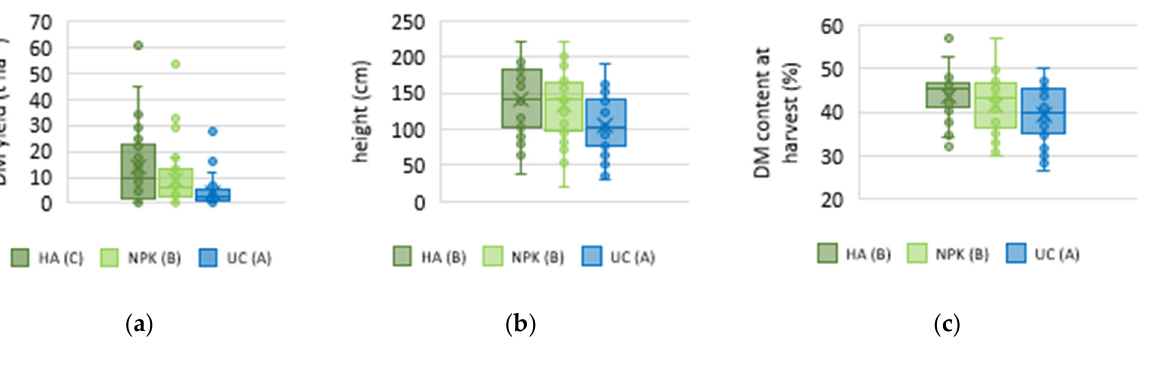
Figure 3. Box plot for DM yield ( a ), crop height ( b ), and DM content at harvest ( c ) according to the treatments HA, NPK, and UC, displaying the minimum, fi rst quartile, median, mean, third quartile, and maximum. The le tt ers A-B-C indicate homogeneous groups according to the MANOVA proce- dure for main e ff ects at a 0.05 signi fi cance level. Table 6. MANOVA of the yield data .